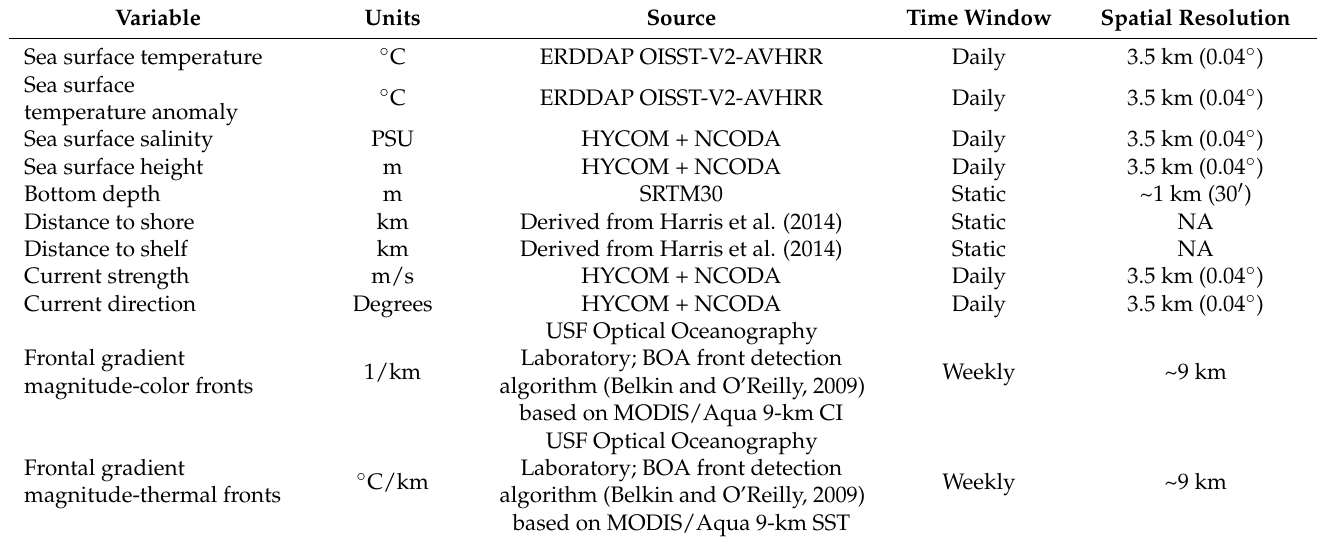
Table 1. Summary of all environmental and oceanographic covariates explored for each species time-at-surface model. Each variable was linked to the dive data by date and spatial location.